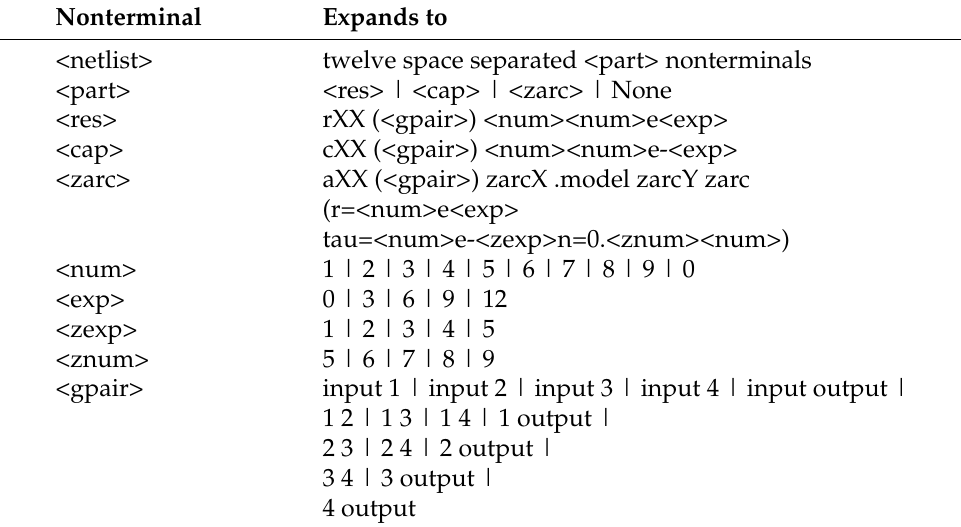
Table 1. Table 1. Production rules.